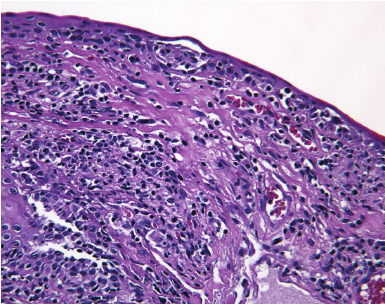
Figure 4: Rare B lymphocytes are positive for CD79a (left conjunctiva, immunoperoxidase staining,